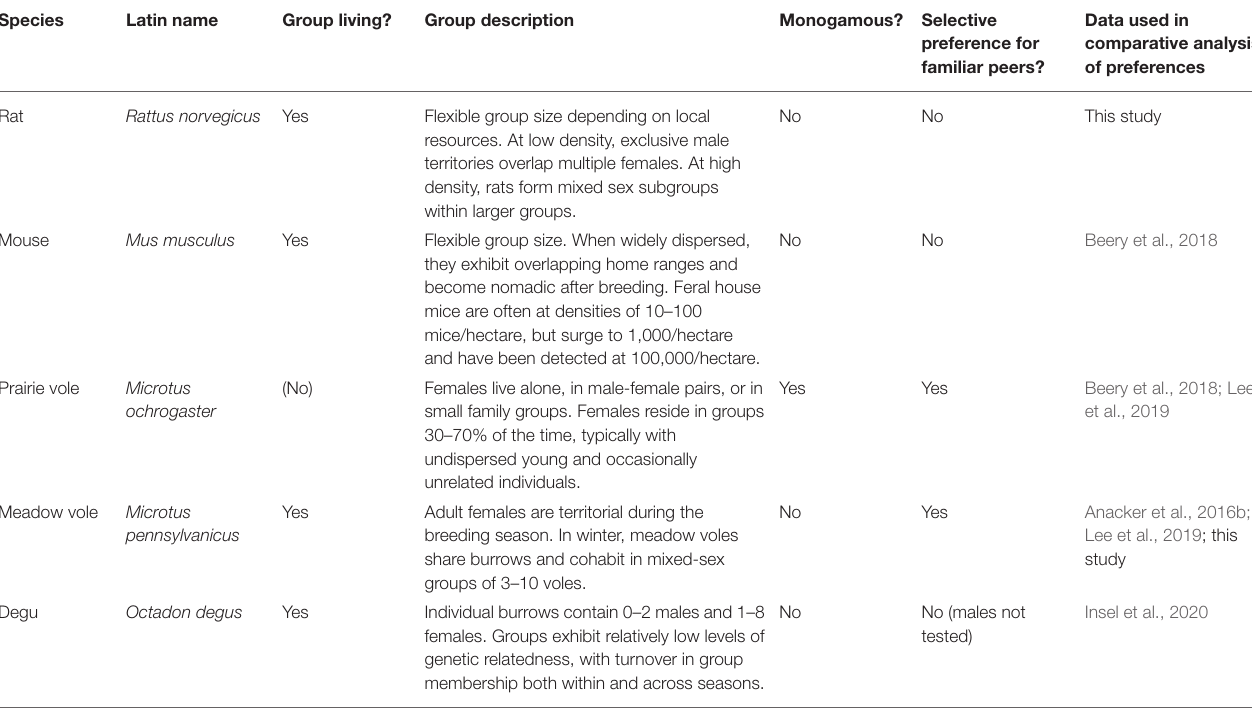
TABLE 1 | Brief descriptions of the social organization of species described in the peer PPT.